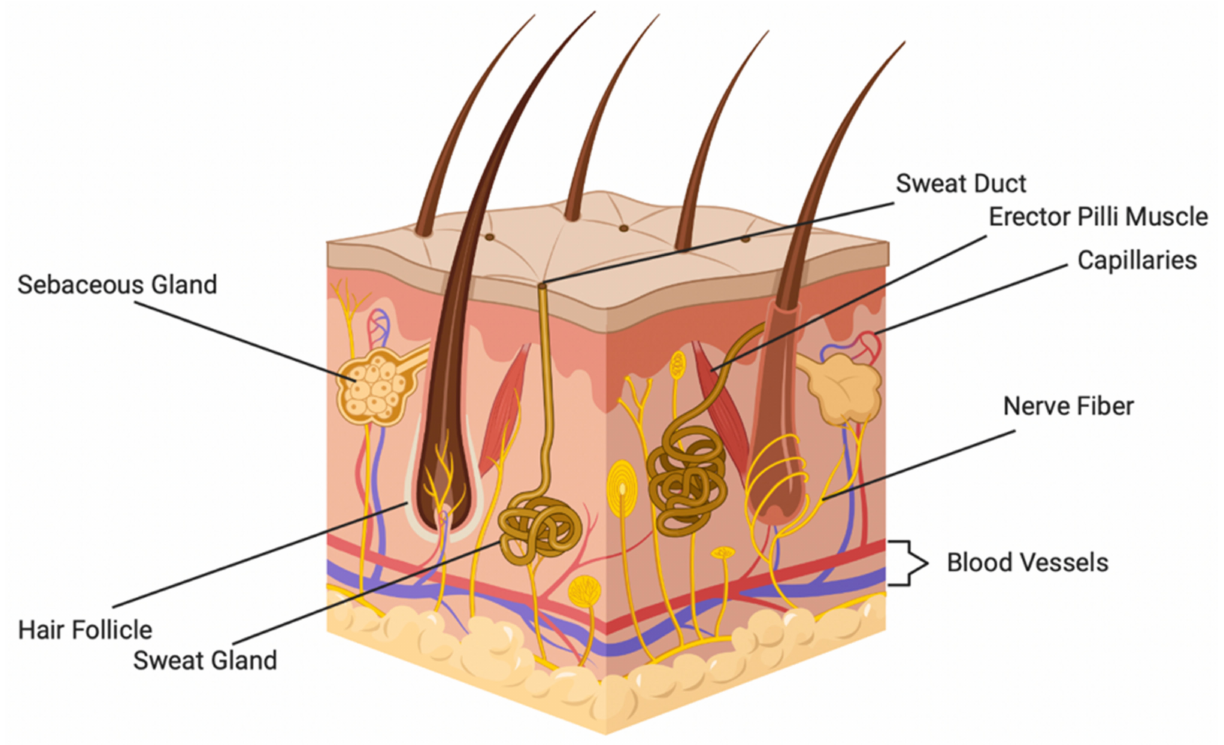
Figure 1. Prominent skin adnexal structures. Adapted from “Anatomy of the Skin” by Biorender.com (accessed on 15 November 2021).